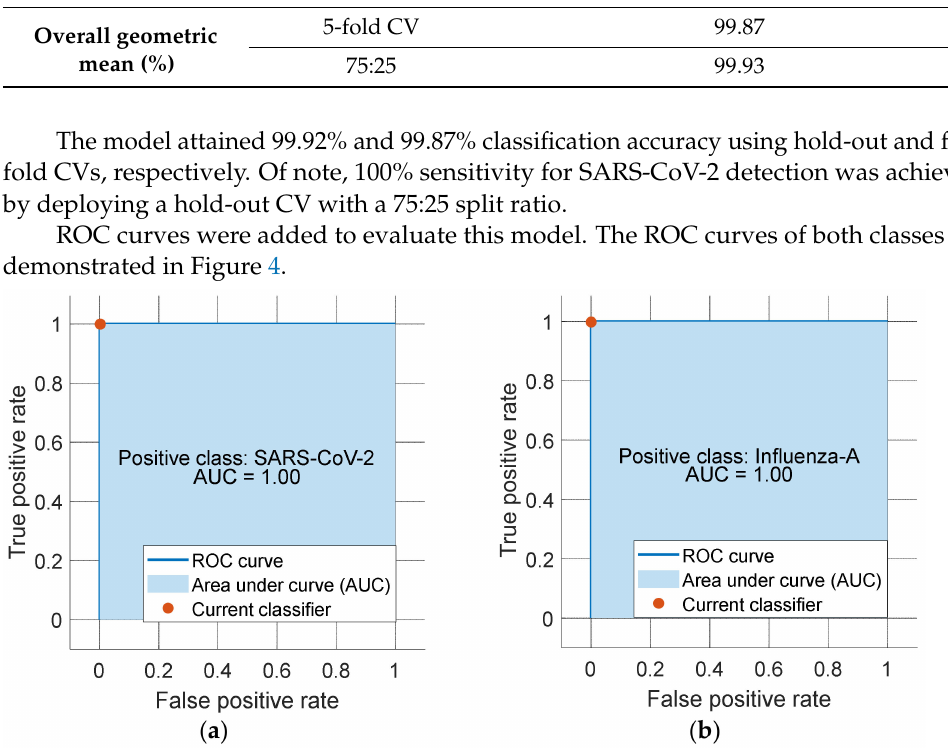
Figure 4. ROC curves of each class ( a ) SARS-CoV-2 and ( b )